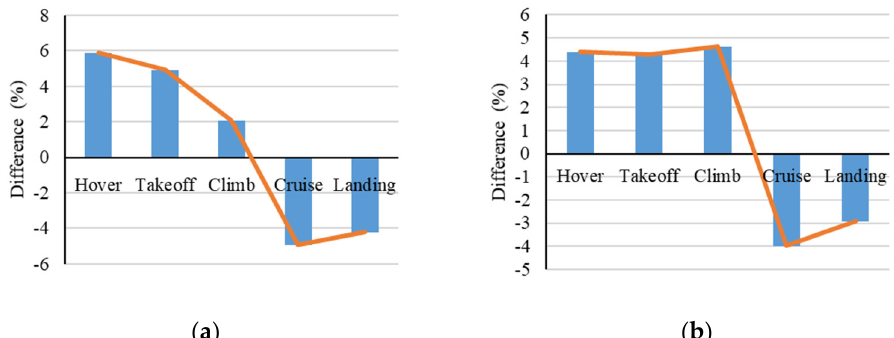
Figure 26. The differences of thrust ( a ) and power ( b ) between the BEMT and CFD method.